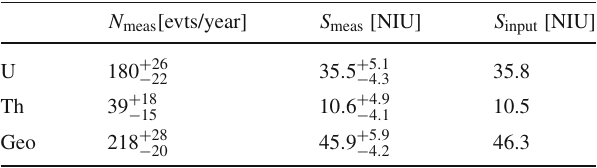
Fig. 10 2-D confidence level of the number of Th versus U antineu- trinos detected after one year of data taking, estimated with 1000 toy experiments (statistical uncertainties only). The confidence level are drawn for [ 1 σ, 8 σ ] . The individual projections for each contribution at the best-fit value are also shown with the statistical significance as dashed